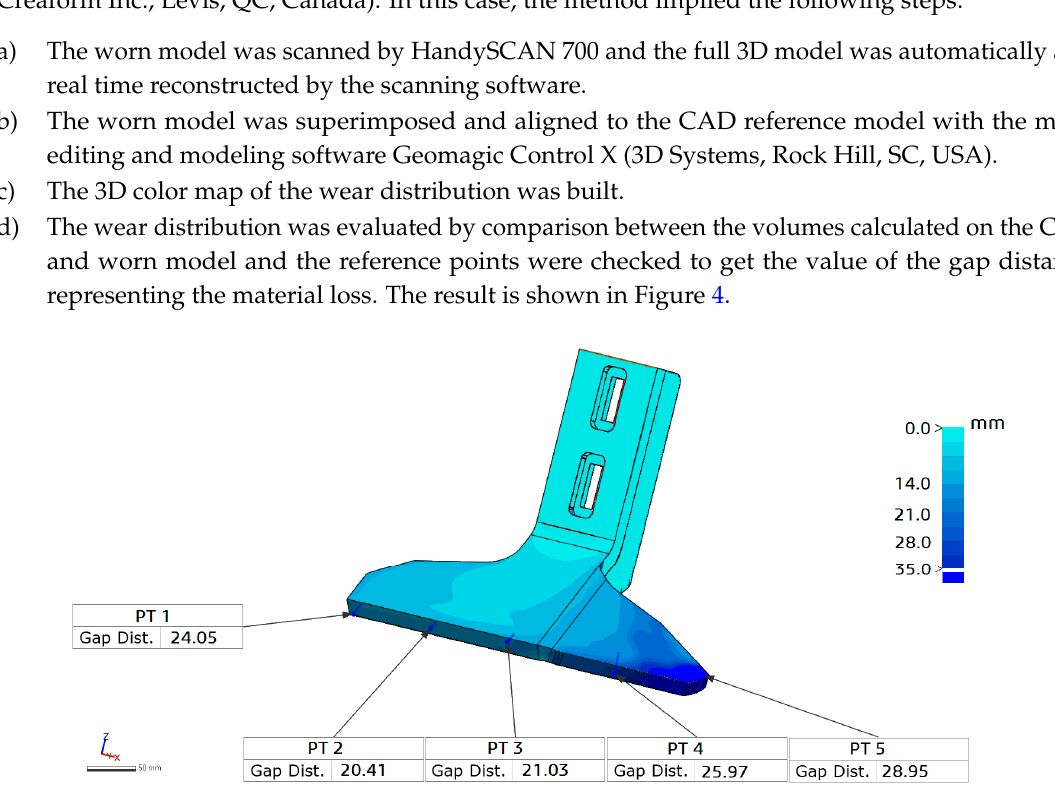
Figure 4. Blade’s 3D wear distribution map (mean values).